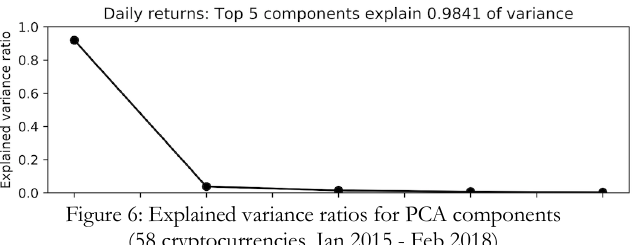
Figure 6: Explained variance ratios for PCA components (58 cryptocurrencies, Jan 2015 - Feb 2018)